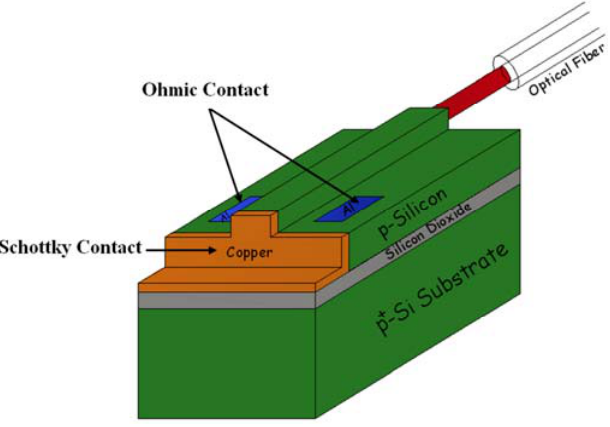
Figure 14. Schematic view of the Cu/p-Si Schottky-barrier-based integrated photodetector proposed by Casalino et al. [63]. Reprinted with permission from M. Casalino, et al . Copyright 2010, American Institute of Physics.